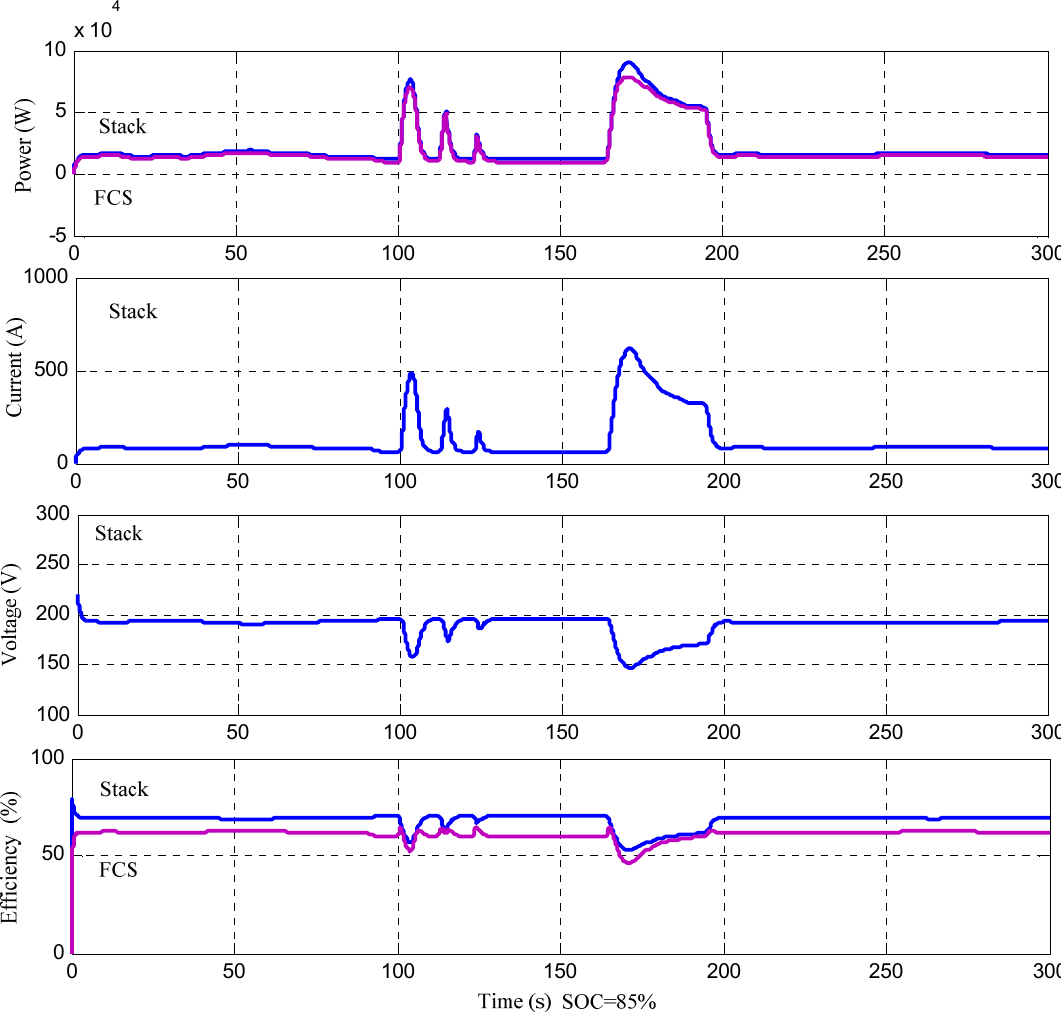
Figure 22. FC characteristics for Case